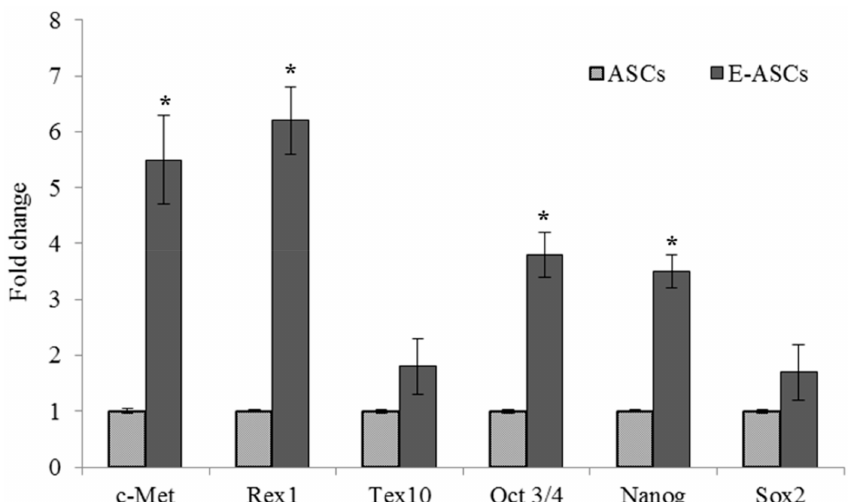
Figure 4. Gene expression of ASCs treated with eugenol. Quantitative RT-PCR was used to evaluate the effect of eugenol on ASCs expression. Data represent fold change relative to ASCs expression after normalization to GAPDH. Bars represent mean ± SD. Significant difference is analyzed by a Student’s t -test, where: *: p < 0.001. ASCs: adipose tissue-derived mesenchymal stem-like cells, E-ASCs: adipose tissue-derived mesenchymal stem-like cells treated with eugenol, Rex1: reduced expression 1, Tex10: testis-expressed 10, Oct4: octamer-binding transcription factor 4.